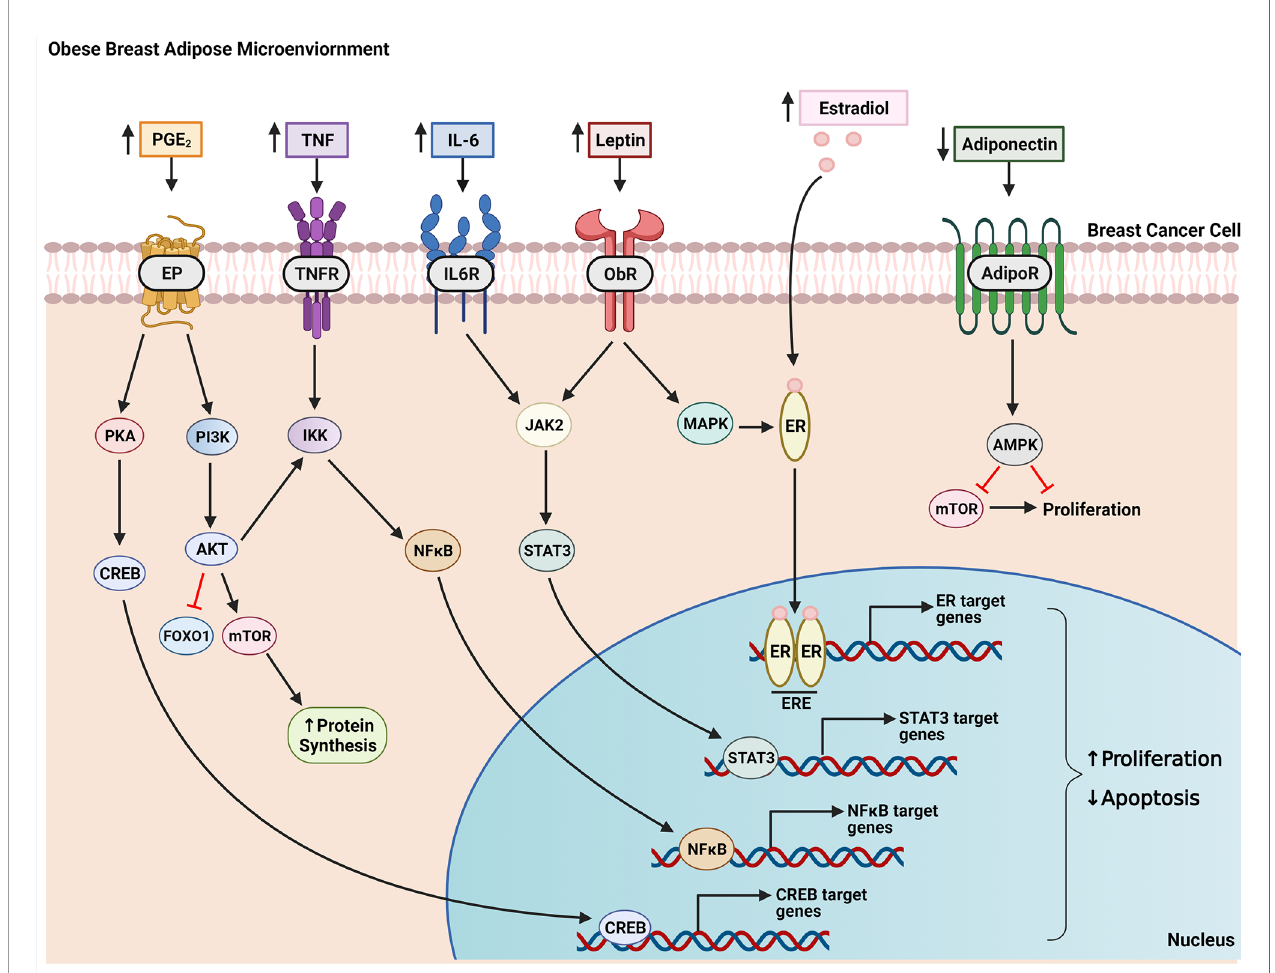
FIGURE 3 | Factors produced in the obese breast microenvironment contribute to the growth of breast cancer. Obesity-induced changes to breast adipose tissue results in increased secretion of in fl ammatory mediators (e.g. PGE 2 , TNF, IL-6) and estradiol along with altered adipokine production. These factors act in a paracrine manner on breast tumor cells growing within this milieu to increase proliferation and decrease apoptosis. For example, PGE 2 signals through EP receptors on tumor cells to activate PKA, which, in turn, stimulates CREB translocation to the nucleus and transcription of genes that promote cell growth. PGE 2 also activates the PI3K pathway resulting in inhibition of FOXO1 and activation of mTOR via AKT, netting a decrease in apoptosis and increase in protein synthesis, a necessary precursor of cell growth. Both AKT and TNF signaling activate IKK leading to expression and translocation of transcription factor NF k B to the nucleus. IL-6 and leptin bind their respective receptors to activate JAK2/STAT3 signaling which promotes nuclear transcription of programs that enhance cell proliferation. Leptin also activates MAPK signaling which can lead to ligand-independent activation of the estrogen receptor (ER). Ligand-dependent (through binding of estradiol) or ligand-independent activation of ER causes receptor dimerization and binding to estrogen response elements (ERE) on target genes. Adiponectin signals through its receptor to activate AMPK signaling resulting in downstream inhibition of mTOR, which decreases proliferation. This inhibitory effect on cell proliferation is diminished in obesity due to decreased adiponectin production by obese breast adipose